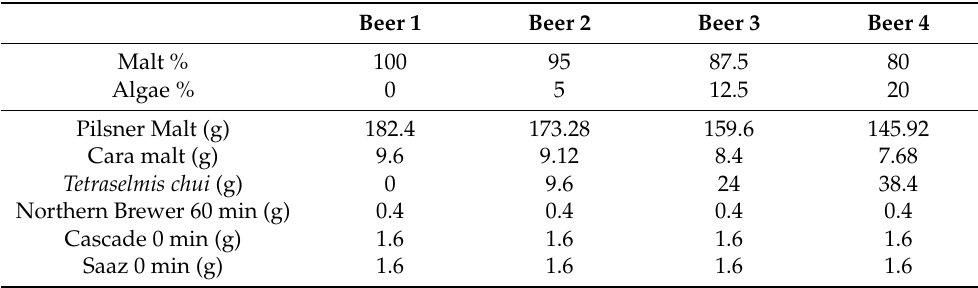
Table 1. Brewing ingredients for 0.8 L volume. Four beers containing different malt:algae ratios were tested in